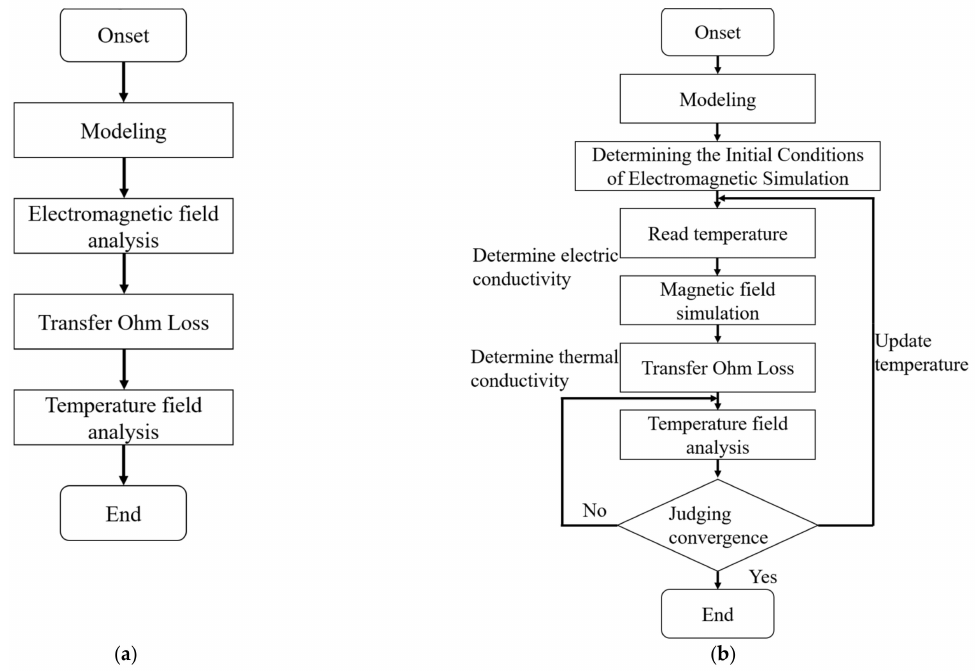
Figure 2. Simulation process of ( a ) one-way coupling and ( b ) two-way coupling.